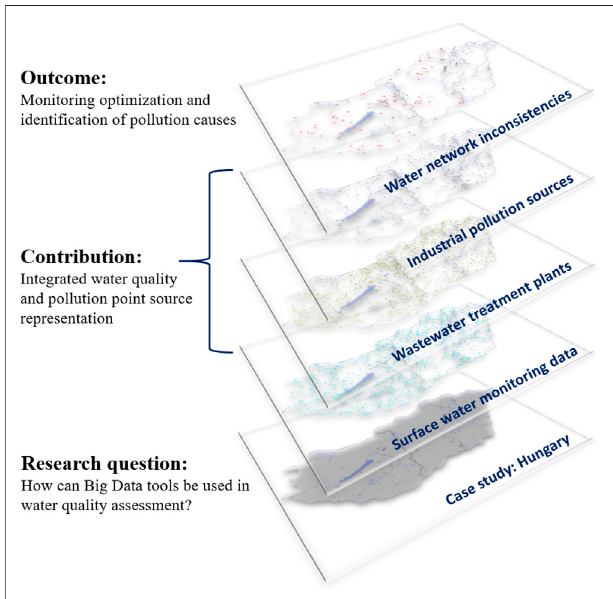
FIGURE1| Thework fl owoftheproposednetworksciencebasedwater quality evaluation method.